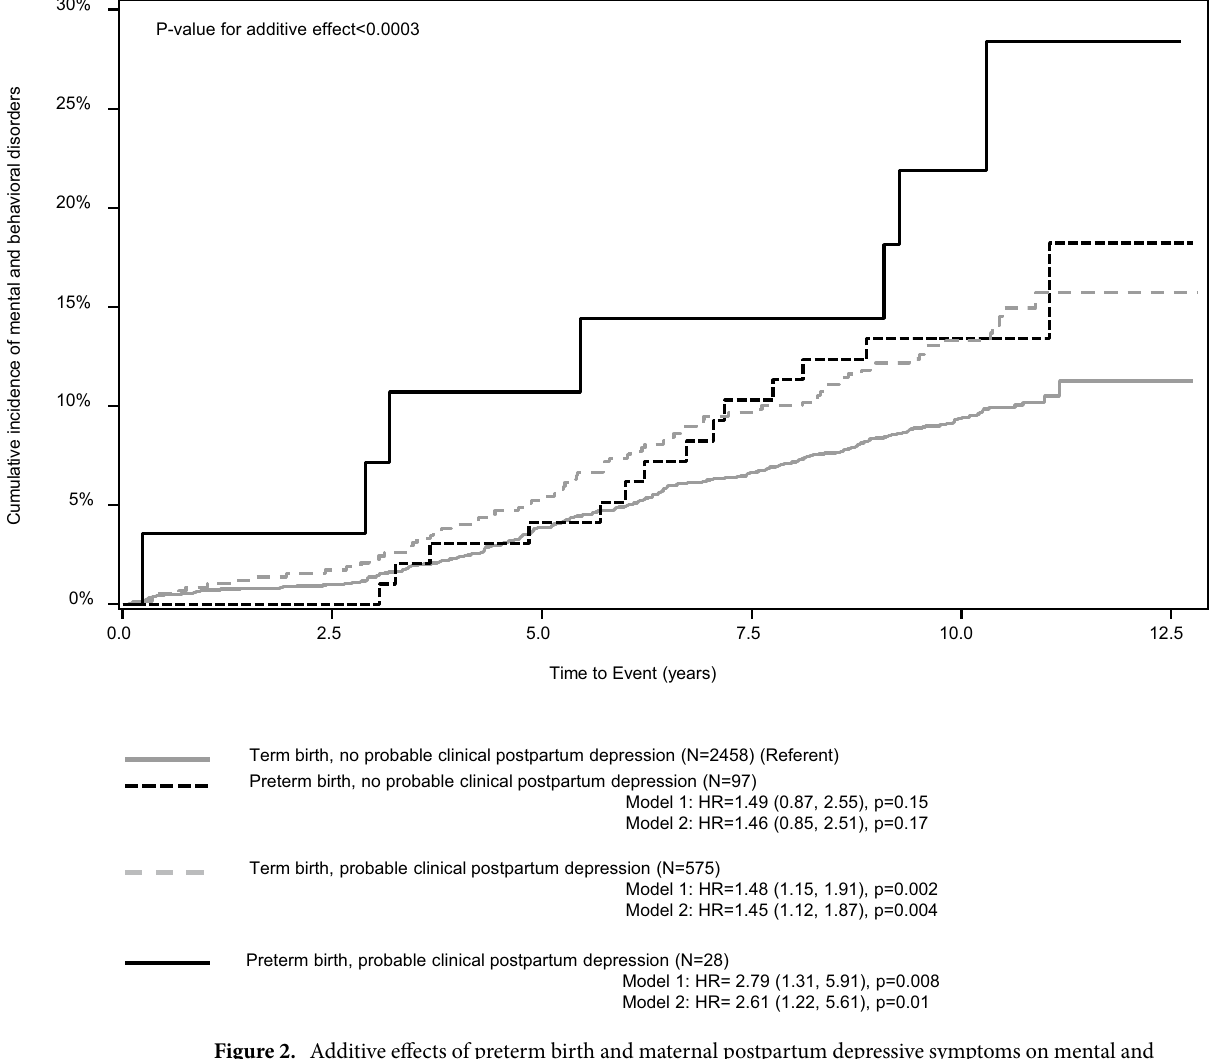
Figure 2. Additive effects of preterm birth and maternal postpartum depressive symptoms on mental and behavioral disorders in children. The lines represent cumulative incidence rates of mental and behavioral disorders until age 8.4–12.8 years in children born at term and whose mother reported no probable clinical postpartum depression (referent), ( a ) in children born preterm and whose mothers reported no probable clinical postpartum depression, ( b ) in children born at term and whose mother reported probable clinical postpartum depression, and ( c ) in children born preterm and whose mother reported probable clinical postpartum depression. HR refers to hazard ratio and 95% CI to 95% Confidence Interval. Model 1 refers to unadjusted associations and Model 2 to associations adjusted for maternal age at delivery, education, smoking and/or alcohol use at any time during pregnancy, delivery mode and child sex. P value for linearity refers to the additive effect of preterm birth and maternal postpartum depression (0 = term, no postpartum depression, 1 = preterm, no postpartum depression or term, postpartum depression, 2 = preterm, postpartum The ability to verify that the associations between preterm birth and maternal PPD symptoms were not explained by maternal history of mood disorders and the ability to take into account the continuity of depres- sive symptomatology from the antenatal to the postpartum stage, both strong predictors of maternal PPD 10,14,24 , are key strengths in this study. We were also able to show that the associations between preterm birth and maternal PPD symptoms, depressive symptoms trajectories and child outcomes were not modified by maternal preeclampsia, premature rupture of membranes or mode of delivery. Other study strengths include prospective study design, large and well-characterized sample, longitudinal measurement of depressive symptoms from the antenatal to the postpartum stage, which allowed us to identify maternal antenatal depressive symptoms before preterm and term delivery, data on maternal mood and child mental and behavioral disorder diagnoses extracted from nationwide registers and null data attrition in child follow-up. However, our study does not unravel the mechanisms underlying the association between preterm birth and maternal PPD symptoms, and mechanisms underlying their association with increased risk of mental and behavioral disorders in children. While data attrition in the child follow-up was null, our study suffers from selective dropout, as the women who participated in the postpartum follow-up and reported PPD symptoms were